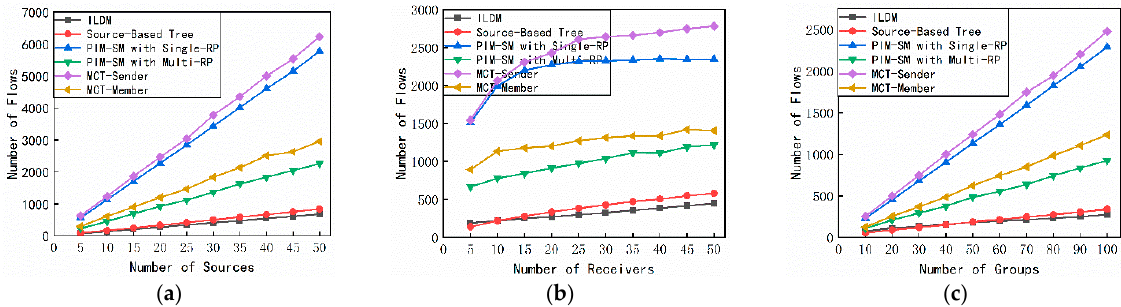
Figure 8. The comparison of maximum link load. ( a ) The variation trends of maximum link load with a different number of sources; ( b ) the variation trends of maximum link load with a different number of receivers; ( c ) The variation trends of maximum link load with a different number of groups.